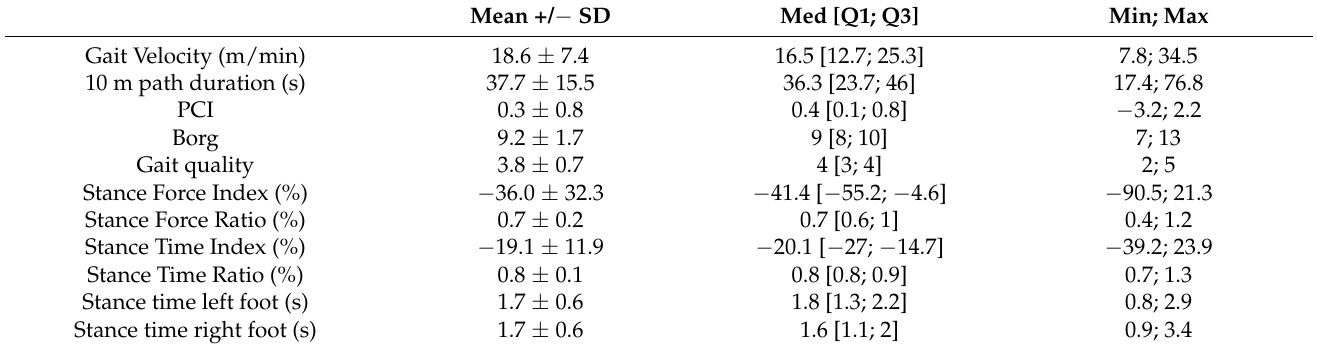
Table 1. Subjects description averaged on all trials, quantitative variables (n = 70).